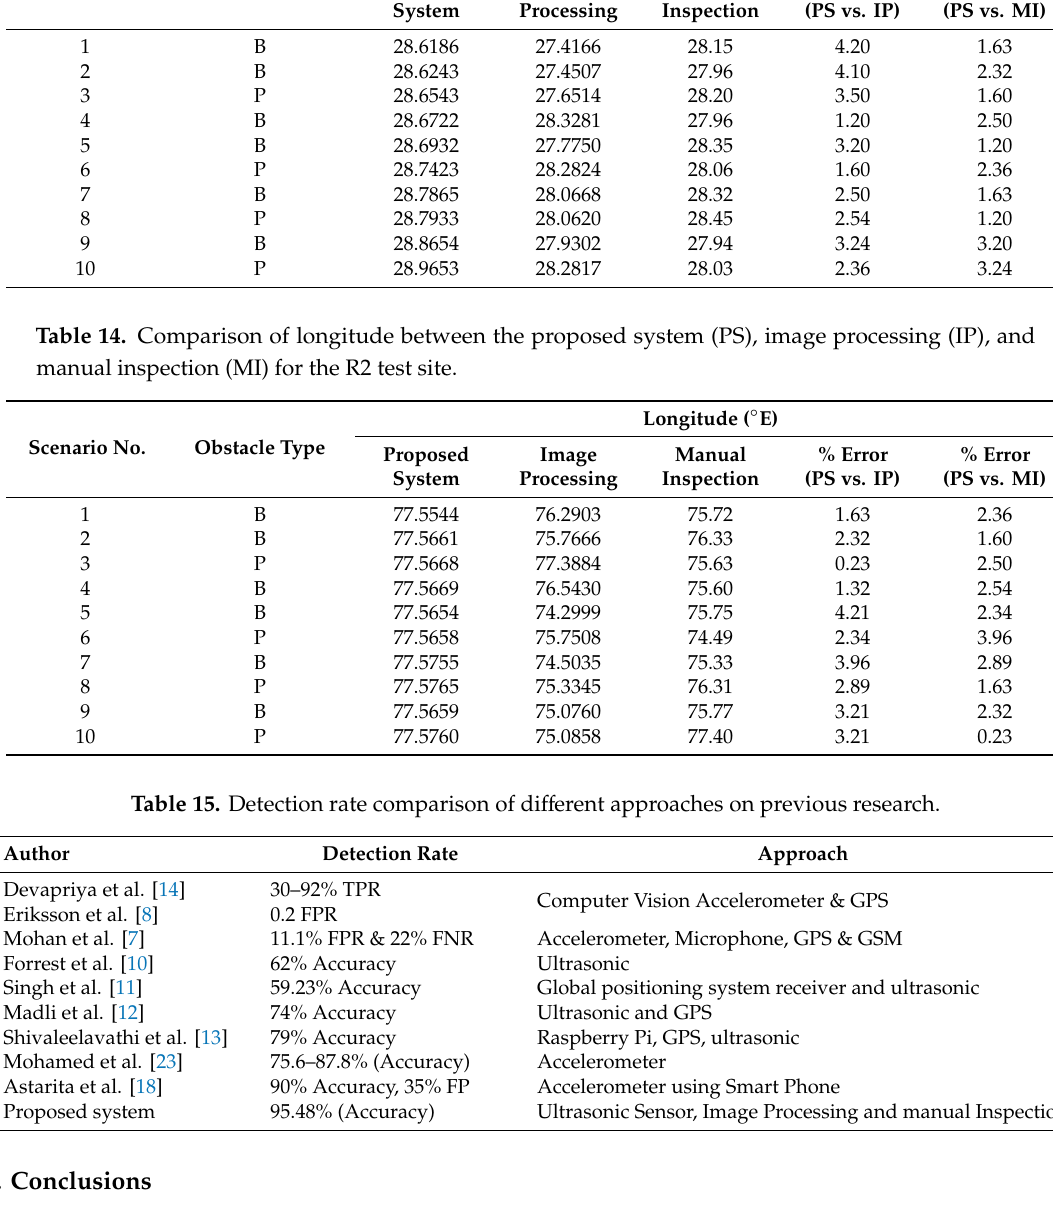
Table 13. Comparison of latitude between the proposed system (PS), Image processing (IP), and Manual inspection (MI) for the R2 test site.